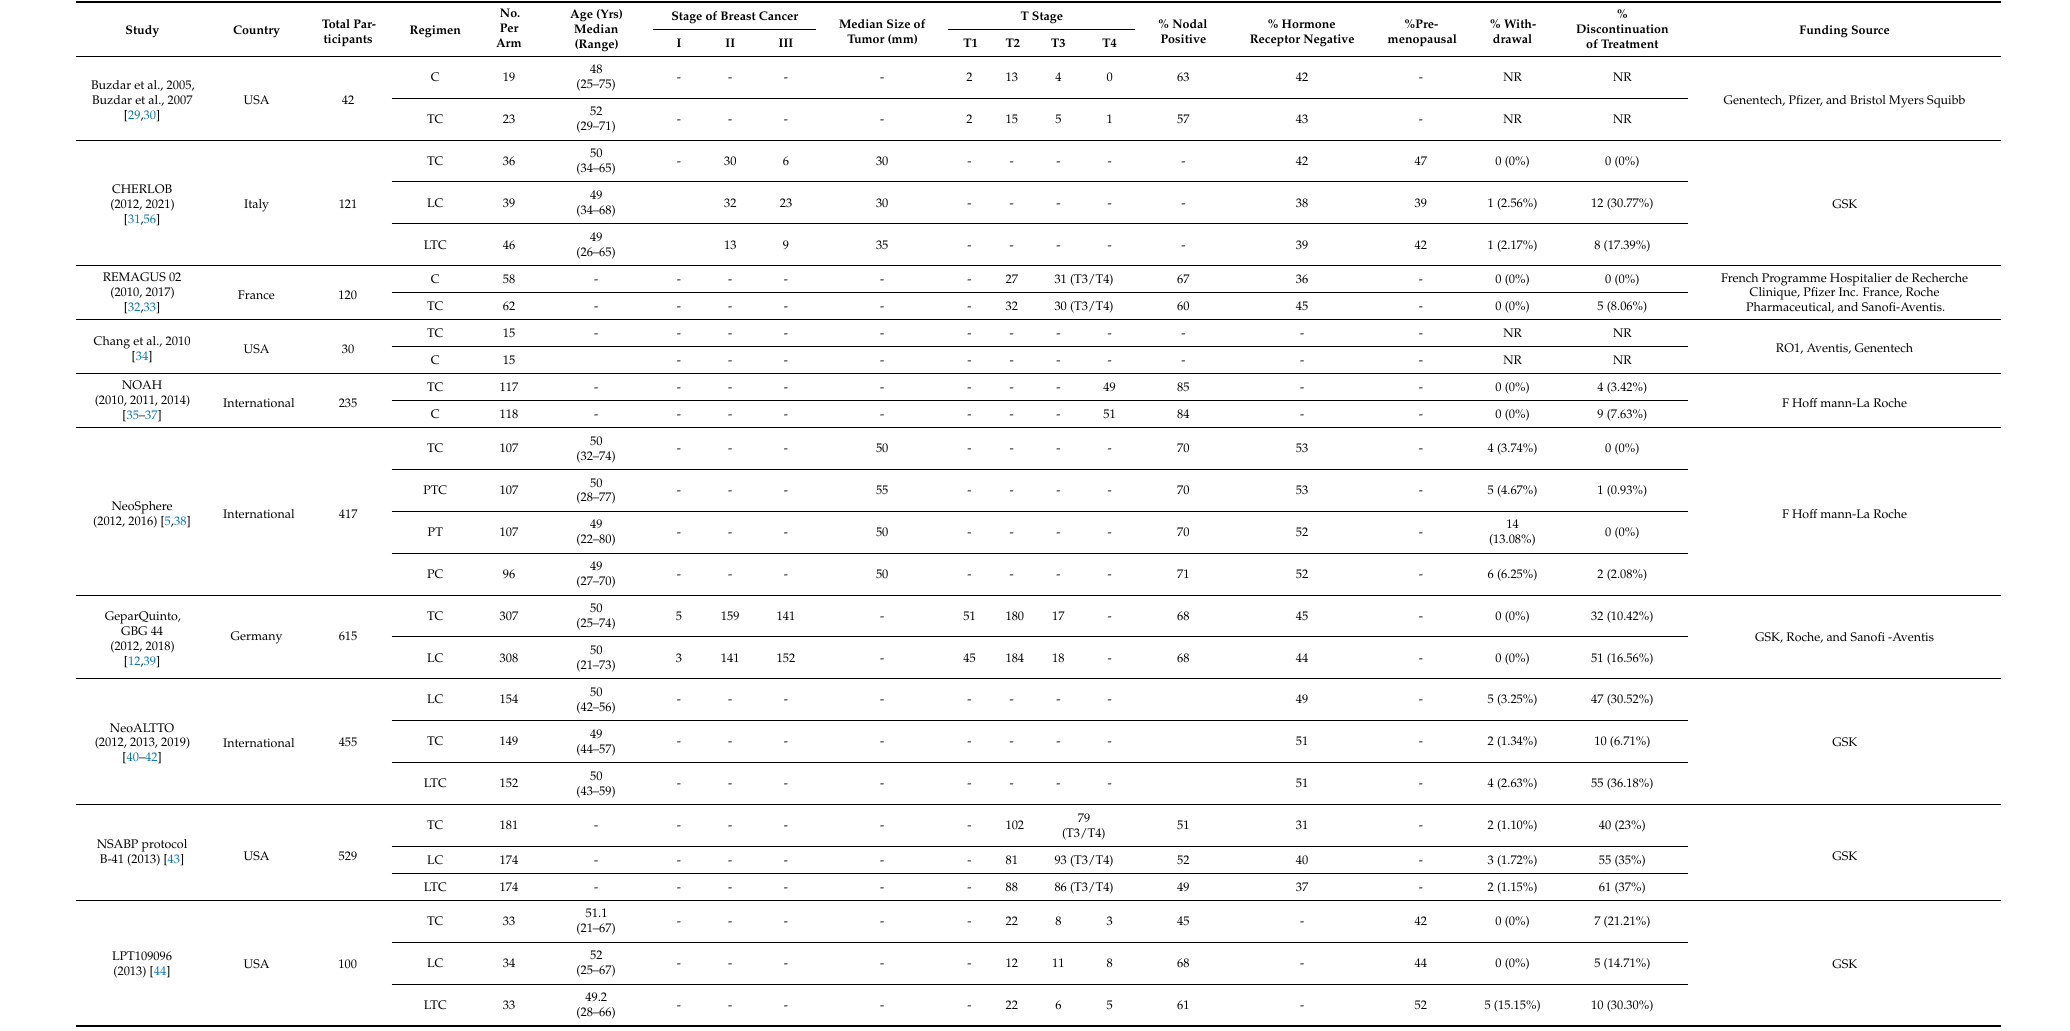
Table 1. Characteristics of the included randomized controlled